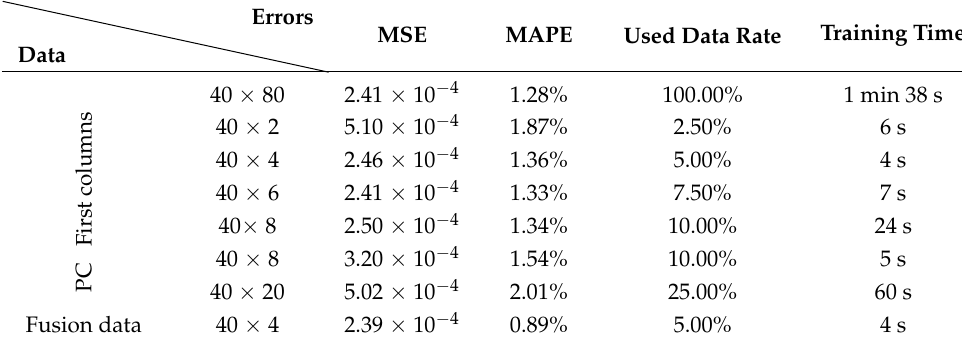
Figure 13. The prediction result of the ( a ) original matrix with different columns and ( b ) PC matrices. Table 2. Error Evaluation